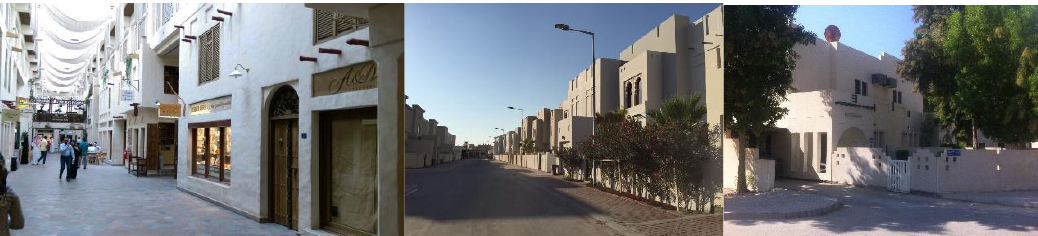
Figure 10 . Commercial complex, Seef area Governmental Housing UoB campus (Authors 2018)